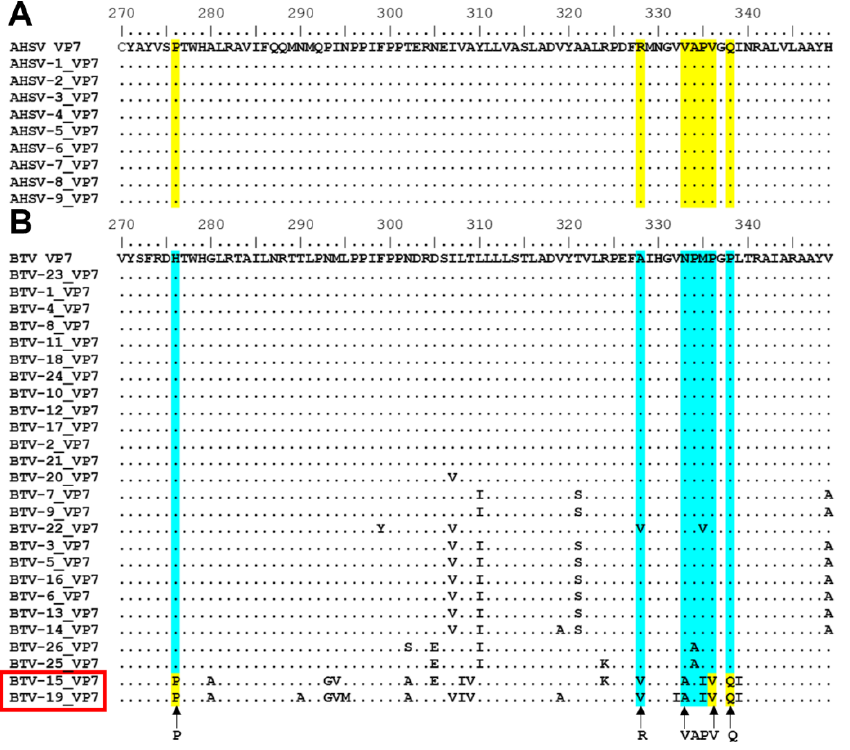
Figure 7. Amino acid sequence conservation analysis of the “276” region among AHSV ( A ) and BTV ( B ) serotypes: Amino acid sequence alignment of AHSV VP7 serotypes 1 to 9 ( A ) and BTV VP7 serotypes 1 to 26 ( B ), with highlighted positions of the “276” region, i.e., positions 276, 328, 333–336, and 338 in yellow for AHSV VP7 and blue for BTV VP7. The consensus sequence of AHSV and BTV VP7 are shown as reference sequences. AHSV VP7 residues are indicated with arrows in ( B ).